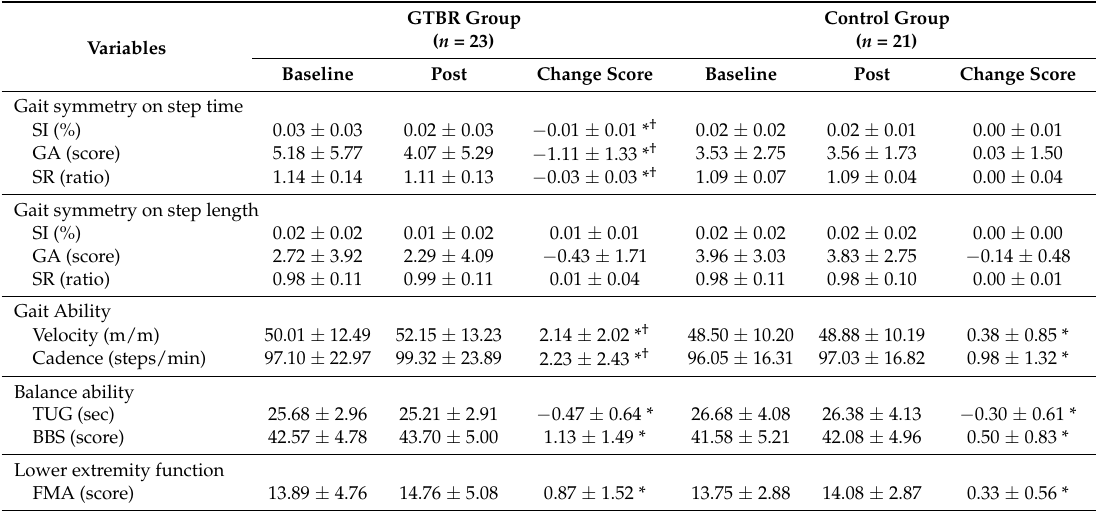
Table 2. Comparison of secondary measures within group and between